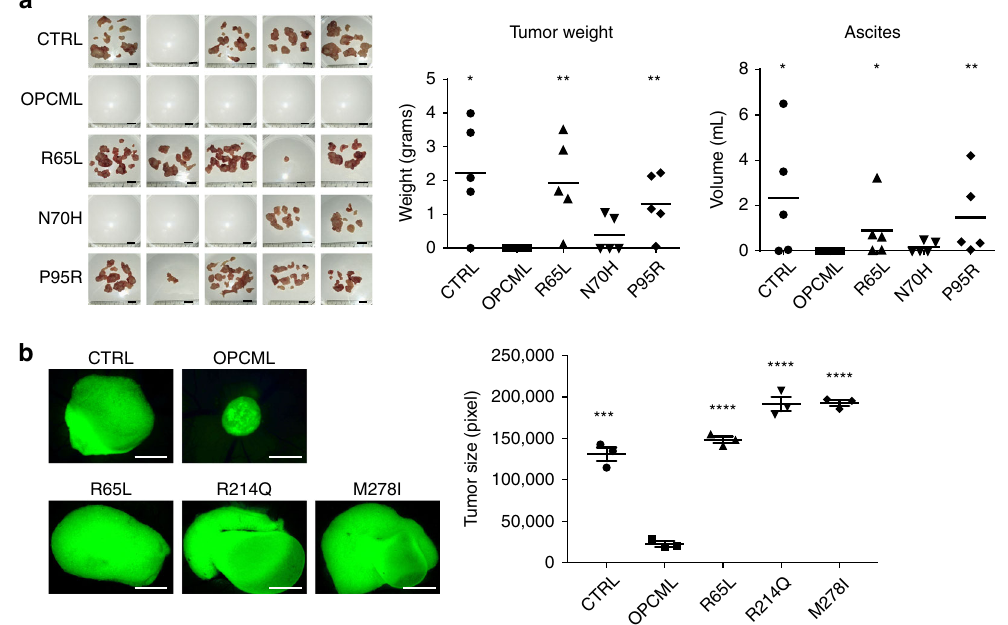
Fig. 8 Point mutations impair OPCML tumor suppressor function in in vivo models. a SKOV3 cells expressing empty vector (CTRL), wild-type (OPCML) or mutant (R65L, N70H and P95R) OPCML were injected intraperitoneally in fi ve female athymic mice each. Tumors and ascites were collected and measured in grams and milliliters, respectively, as indicated. The mean is indicated by a line in the dot plots. Student t -test compares CTRL and mutants to wild-type OPCML: * p < 0.05, ** p < 0.01. Scale bar = 1 cm. b SKOV3 cells expressing GFP and the indicated constructs were grown embedded in Matrigel on top of chick chorio – allantoic membranes. Tumors were excised, imaged and the GFP-positive area measured. Scale bar = 500 μ m. The graph shows the mean ± s.e.m. of three eggs. Student t-test compares CTRL and mutants to wild-type OPCML: *** p < 0.001, **** p <